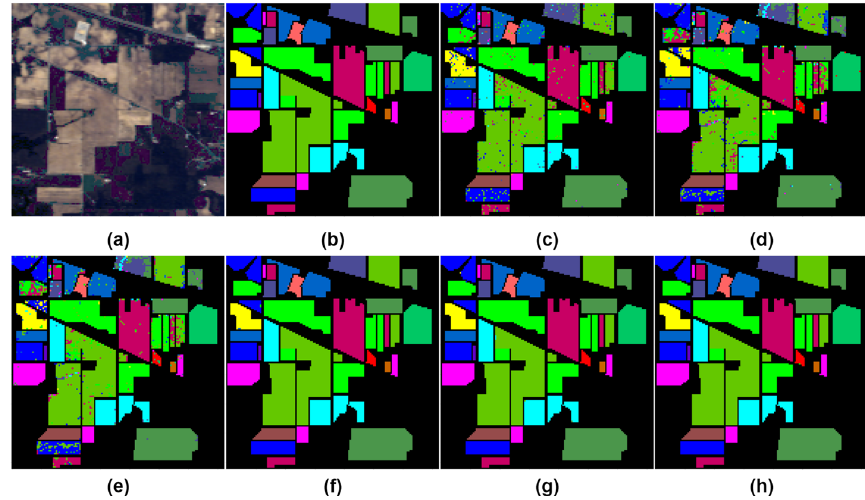
Fig. 6 The classification map for the Indian Pines dataset. a RBG Image b Ground Truth c – e Predicted classification maps for HybridSN, single U-Net, and CEU-Net with no patching respectively. f – h Predicted classification maps for HybridSN, single U-Net, and CEU-Net with patching with a patch size of 10x10